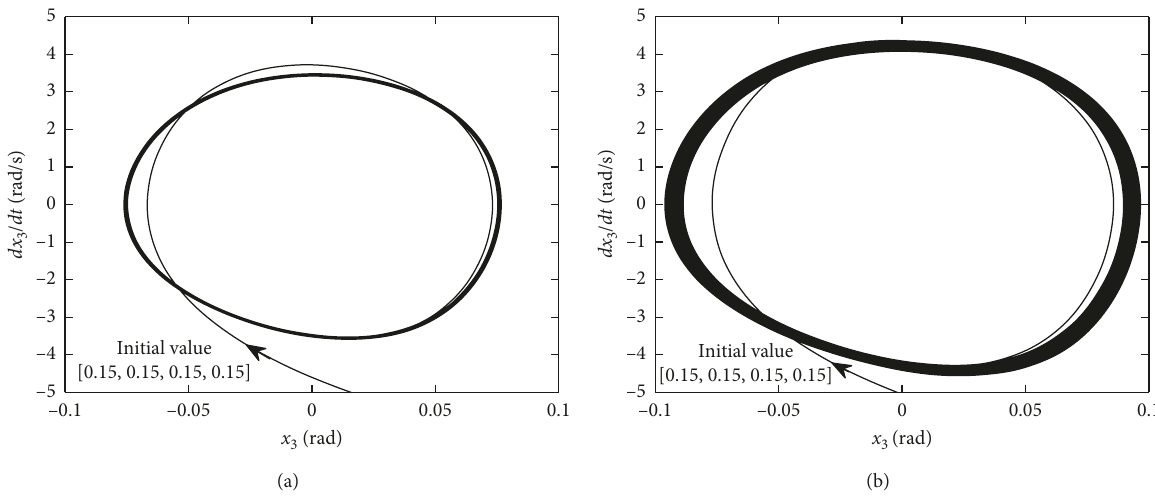
Figure 5: Phase trajectory contrast diagram of the system with different dampings: (a) C � 20; (b) C � 10.